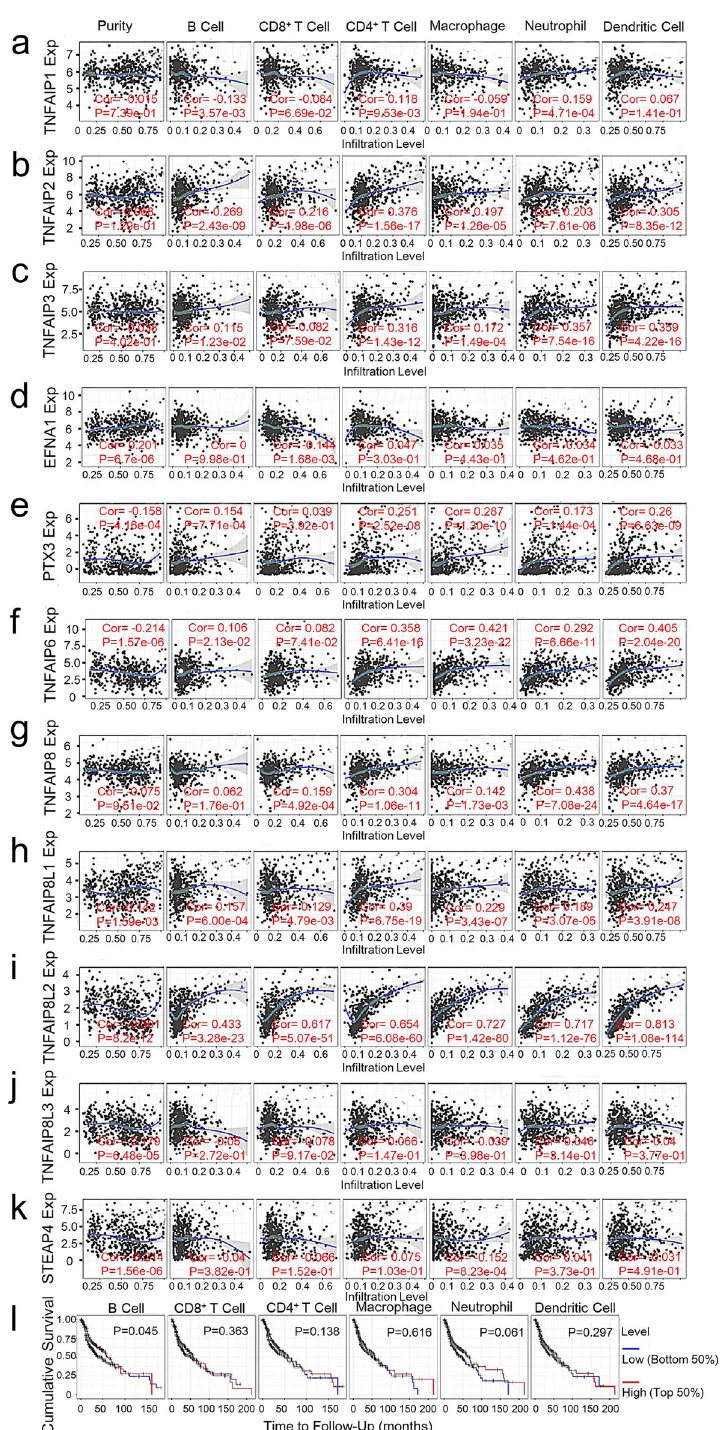
Figure 7. The correlations between immune cell infiltration and TNFAIPs and prognosis. The correlations between the abundance of immune cells and the expression of ( a ) TNFAIP1, ( b ) TNFAIP2, ( c ) TNFAIP3, ( d ) EFNA1, ( e ) PTX3, ( f ) TNAFIP6, ( g ) TNAFIP8, ( h ) TNAFIP8L1, ( i ) TNAFIP8L2, ( j ) TNAFIP8L3, and ( k ) STEAP4 in HNC. ( l ) The OS curve of HNC patients stratified by immune cell infiltration